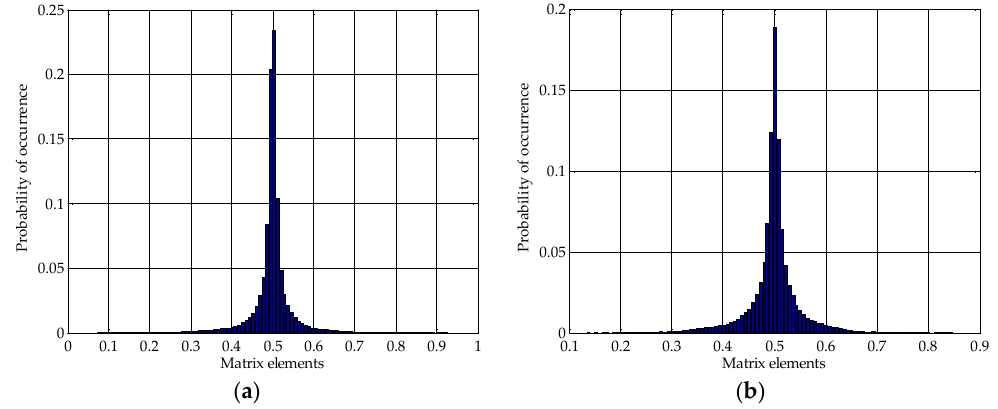
u v for block size 2 2  : ( a ) Image Lena; 1 1 for block size 2 × 2: ( a ) Image Lena; 1